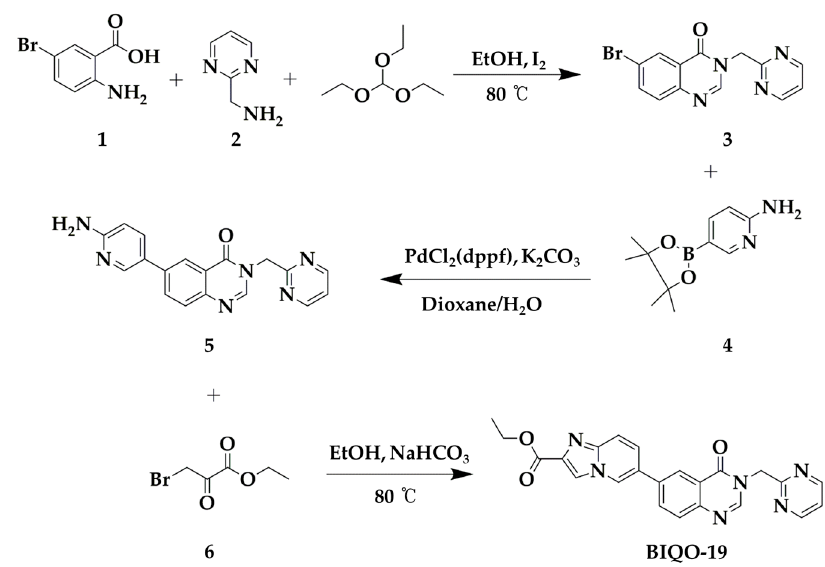
Scheme 1. Synthetic method for